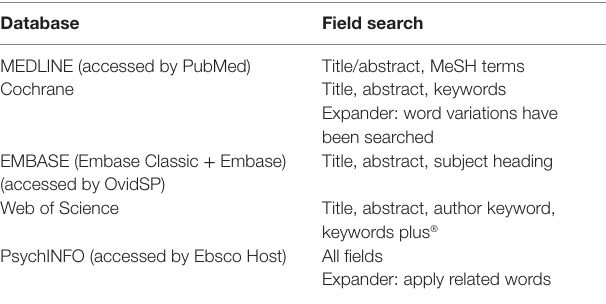
TABLe 1 | Search terms in the databases. (implantable OR